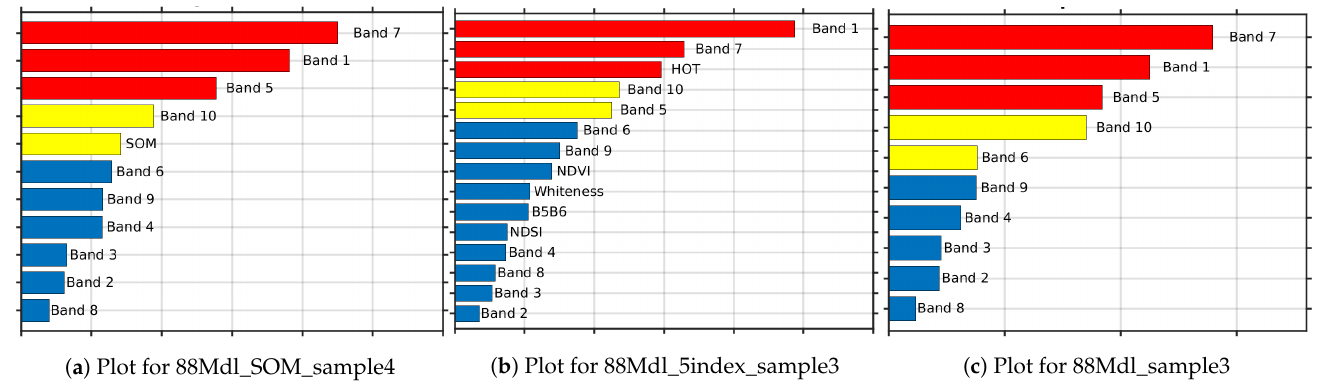
Figure 8. The importance plot for three best models, which are ( a ) the model trained on sample 4 with SOM as input, ( b ) the model with 5 indices trained on sample 3 and ( c ) the base model with 10 wavelength bands trained on sample 3. Model ( a ) has the best performance on all metrics in the intra-group, while model ( b , c ) has the best performance on omission error and correctness, respectively. Red and yellow bars represent the top 5 important features and blue bars represent the importance of the rest